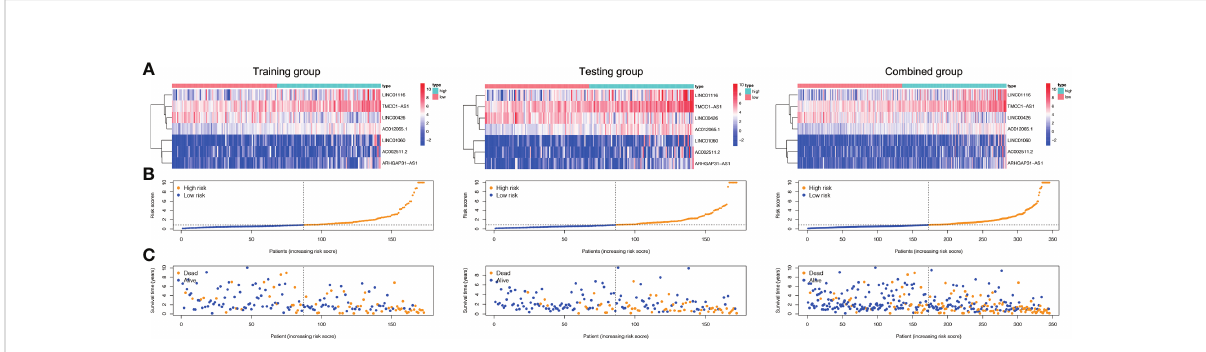
FIGURE 5 Risk score of the three groups. (A) Heatmap of the three-gene signature in the training, testing, and combined groups. (B) Allocation of individuals with various risk scores in the training, testing, and combined groups. (C) Survival status of individuals with various risk scores in the training, testing, and combined